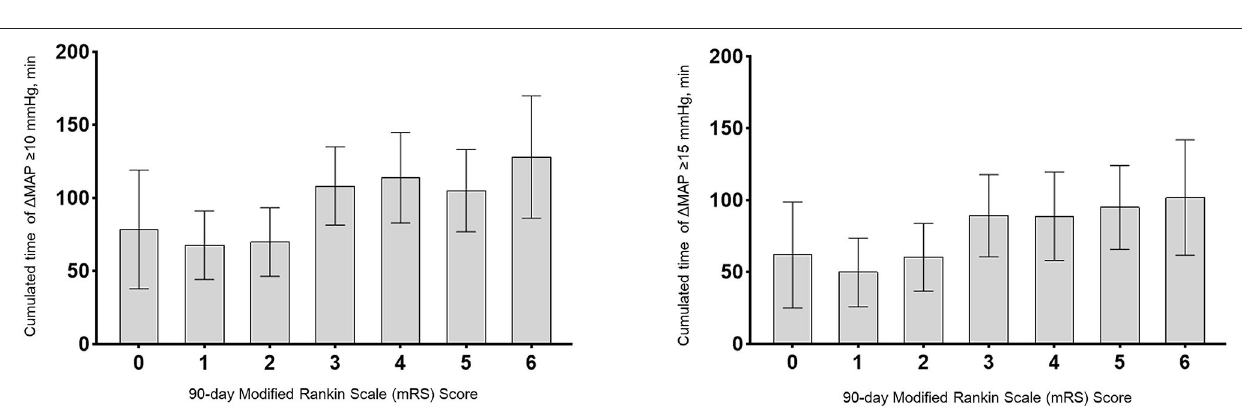
FIGURE 2 | Association of cumulated time (minutes) with functional outcomes at 90 days. Cumulated times with MAP drop more than 10 mmHg or 15 mmHg were plotted per each modified Rankin Scale (mRS) score at 90 days. Bar graphs represent cumulated time with MAP drop for each mRS score category; Error bars indicate the 95%